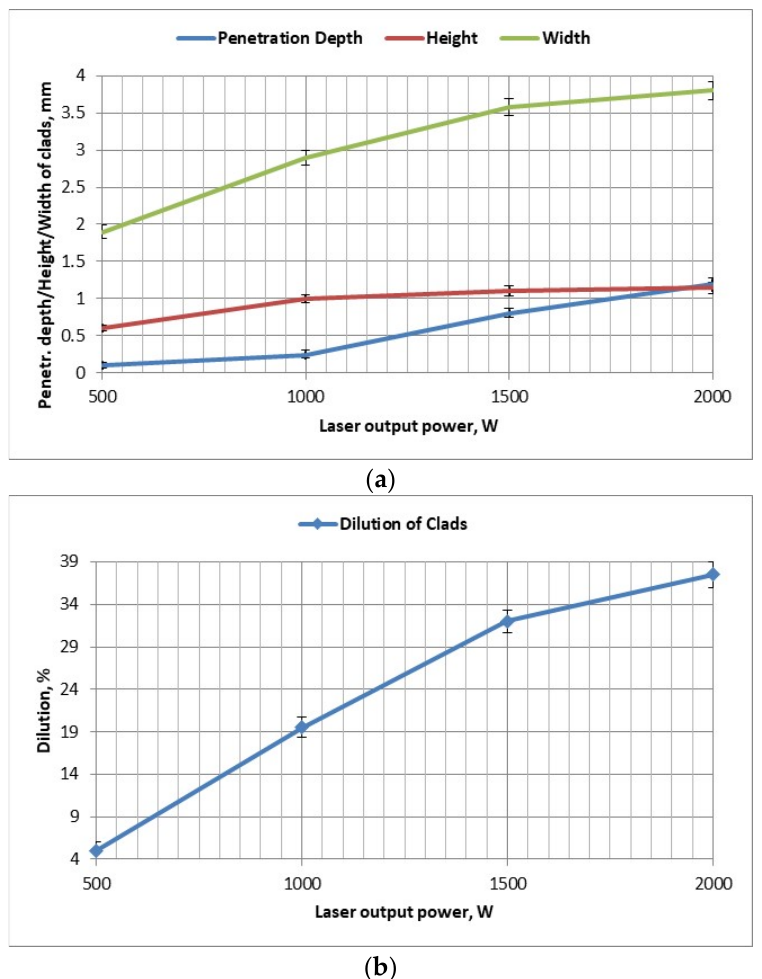
Figure 6. Influence of the laser output power on the geometry ( a ) and dilution rate ( b ) of the stringer beads produced by laser cladding of experimental composite NiCrBSi/WC + W 2 C powder (Tables 2 and 3).